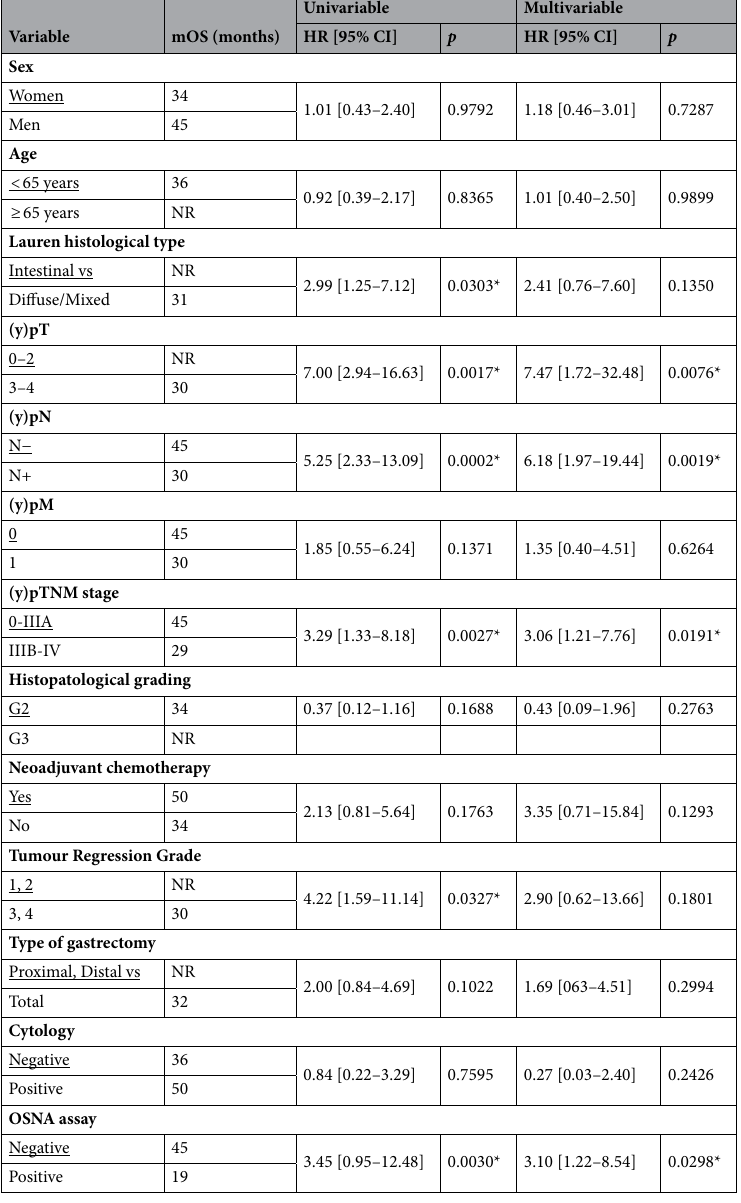
Table 2. Univariable and multivariable analysis of overall survival. Reference (control) variables were underlined. *Statistically significant results. mOS median overall survival, HR hazard ratio, CI confidence interval, (y)pT (post neoadjuvant) pathological primary tumour stage, (y)pN (post neoadjuvant) pathological nodal stage, (y)pM (post neoadjuvant) pathological distant metastasis stage, TNM tumour, node, metastasis, G grade, OSNA One-Step Nucleic Acid Amplification Assay, NR not